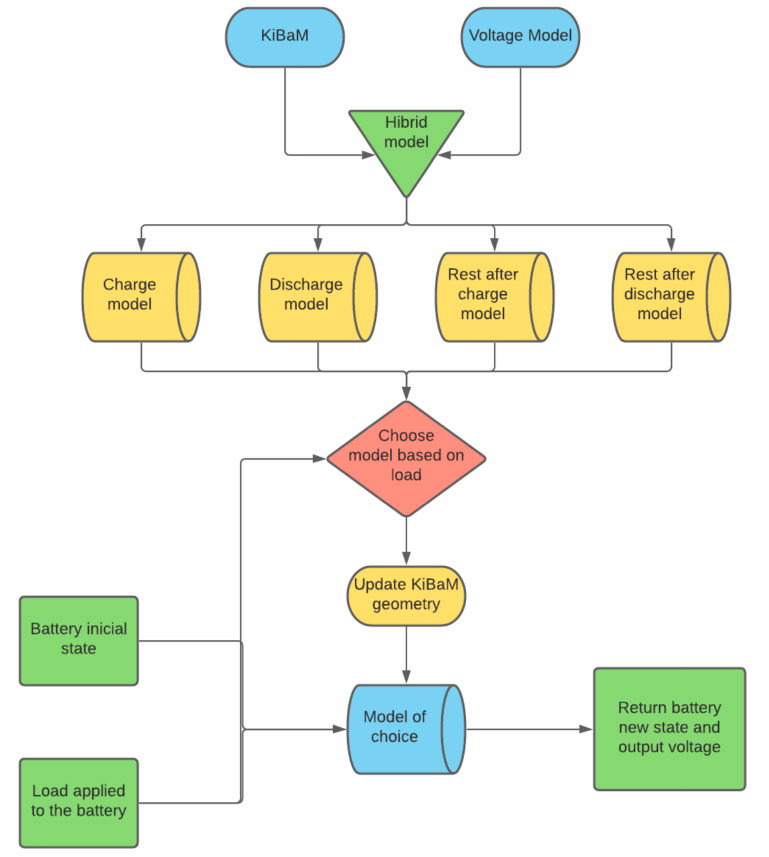
Figure 6. The four-way proposed model